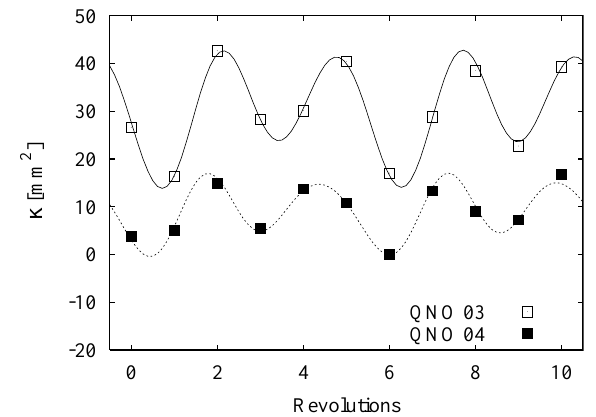
FIG. 7. Theoretical expression for the quadrupole moment fit- ted to measured data. Here, seven turns (14 data points) were used to determine ten free parameters (emittances, betatron and dispersion mismatches, and the tunes), but there is a relatively good match also for the subsequent turns. The measured detun- ings of the beamwidth oscillation frequencies were quite signifi- cant, D Q h (cid:1) 0.01 and D Q y (cid:1) 0.05 (as compared to the tunes measured from position oscillations).